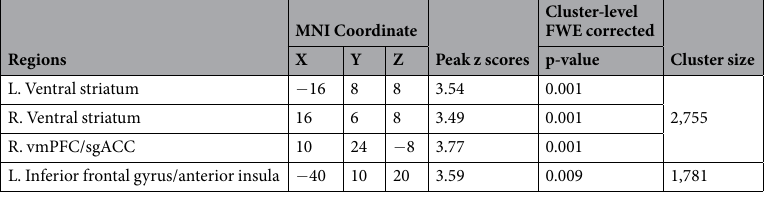
Association between resting neural activity and the extent of moral development. Partial correlation analyses (controlling for Openness and Neuroticism) were conducted to illustrate the associa- tion between resting CBF in the VS, vmPFC/sgACC, and IFG/AIS regions and the DIT-2 N2 score, an index describing the extent to which a person exhibits post-conventional moral thinking. For this analysis, functional regions-of-interest (ROIs) for VS, vmPFC/sgACC, and IFG/AIS were derived from the resting CBF analysis described above. DIT-2 N2 scores were positively correlated with resting CBF values in VS (r = 0.386, p = 0.005) and vmPFC/sgACC (r = 0.340, p = 0.007; Fig. 2), but not with those of IFG/AIS ( p > 0.1). No correlations were observed between resting CBF and the personality variables (Openness and Neuroticism, both p > 0.2). To val- idate the association between DIT-2 N2 scores and resting CBF (i.e., VS and vmPFC/sgACC) in independently defined ROIs, and confirm that these two regions defined by our CBF analysis are consistent with the regions sen- sitive to reward valuation and subjective value across prior studies, we conducted additional analyses with ROIs defined from a previous meta-analysis study by Bartra et al . 24 . The additional partial correlation analysis revealed similar results, i.e., that DIT-2 N2 scores were positively correlated with resting CBF values in the VS (r = 0.319, p < 0.05, Fig. 2C) and vmPFC/sgACC (r = 0.263, p < 0.05, Fig. 2D).